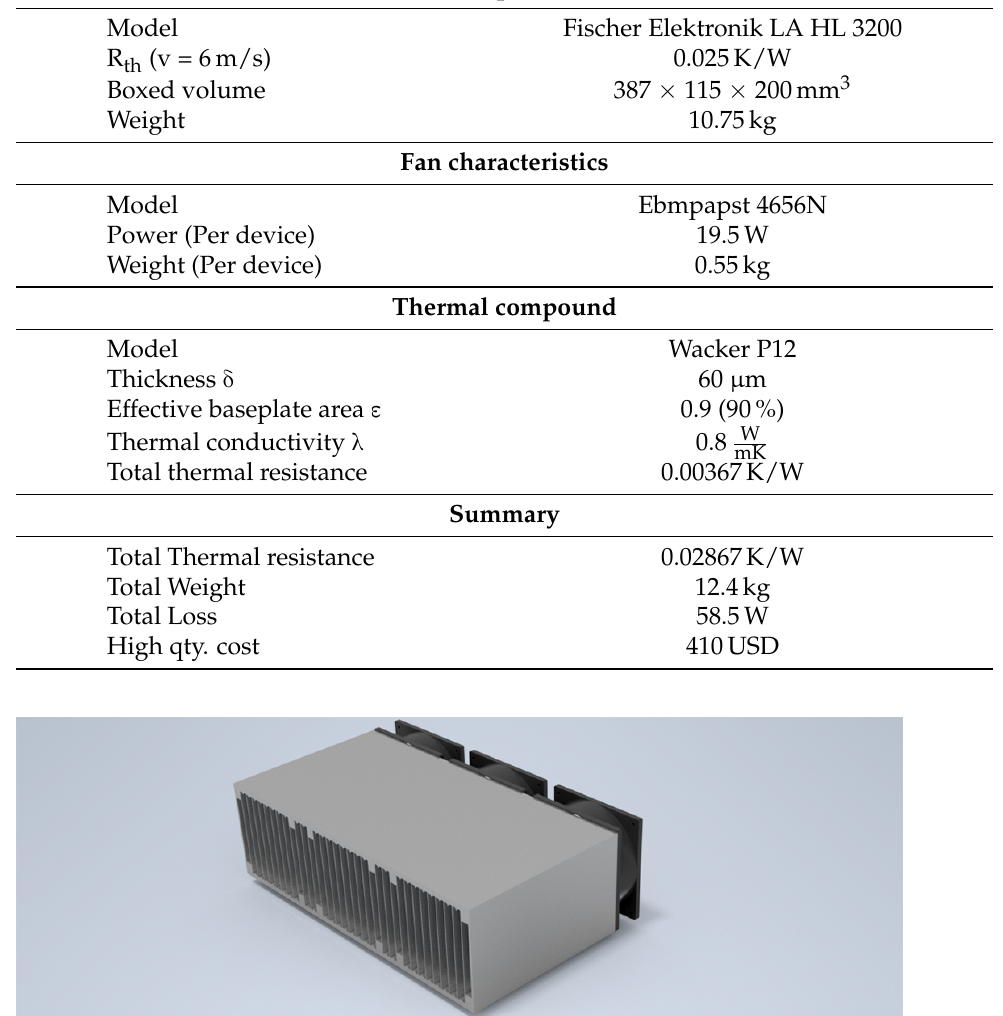
Figure 6. Heatsink: Fischer Elektronik LA HL 3200 R th 0.025K/W